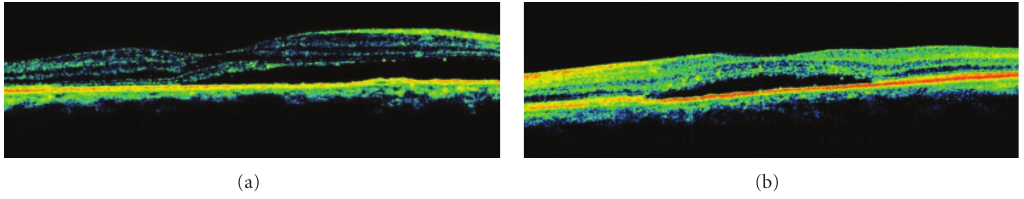
Figure 1: (a) Serous retinal detachment associated with latanoprost/timolol fixed combination use right eye view of the OCT. (b) Serous retinal detachment associated with latanoprost/timolol fixed combination use left eye view of the OCT.